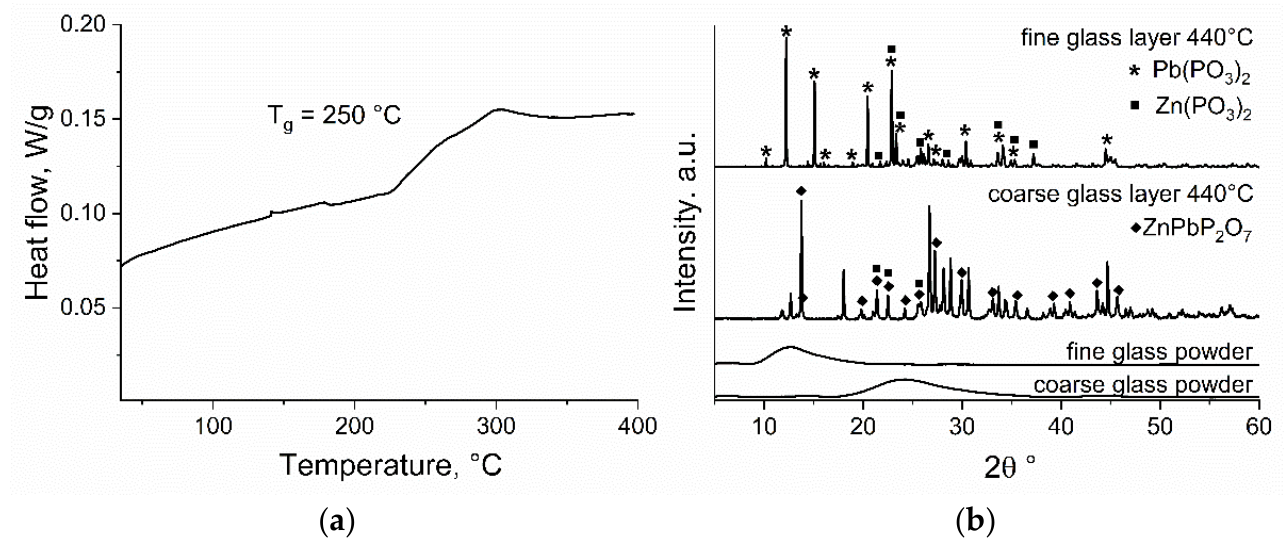
Figure 2. DSC for coarse powder ( a ) and XRD for coarse and fine powders and fired layers ( b ). Reprinted with permission from [35]. 2020, Czech Chemical Society.